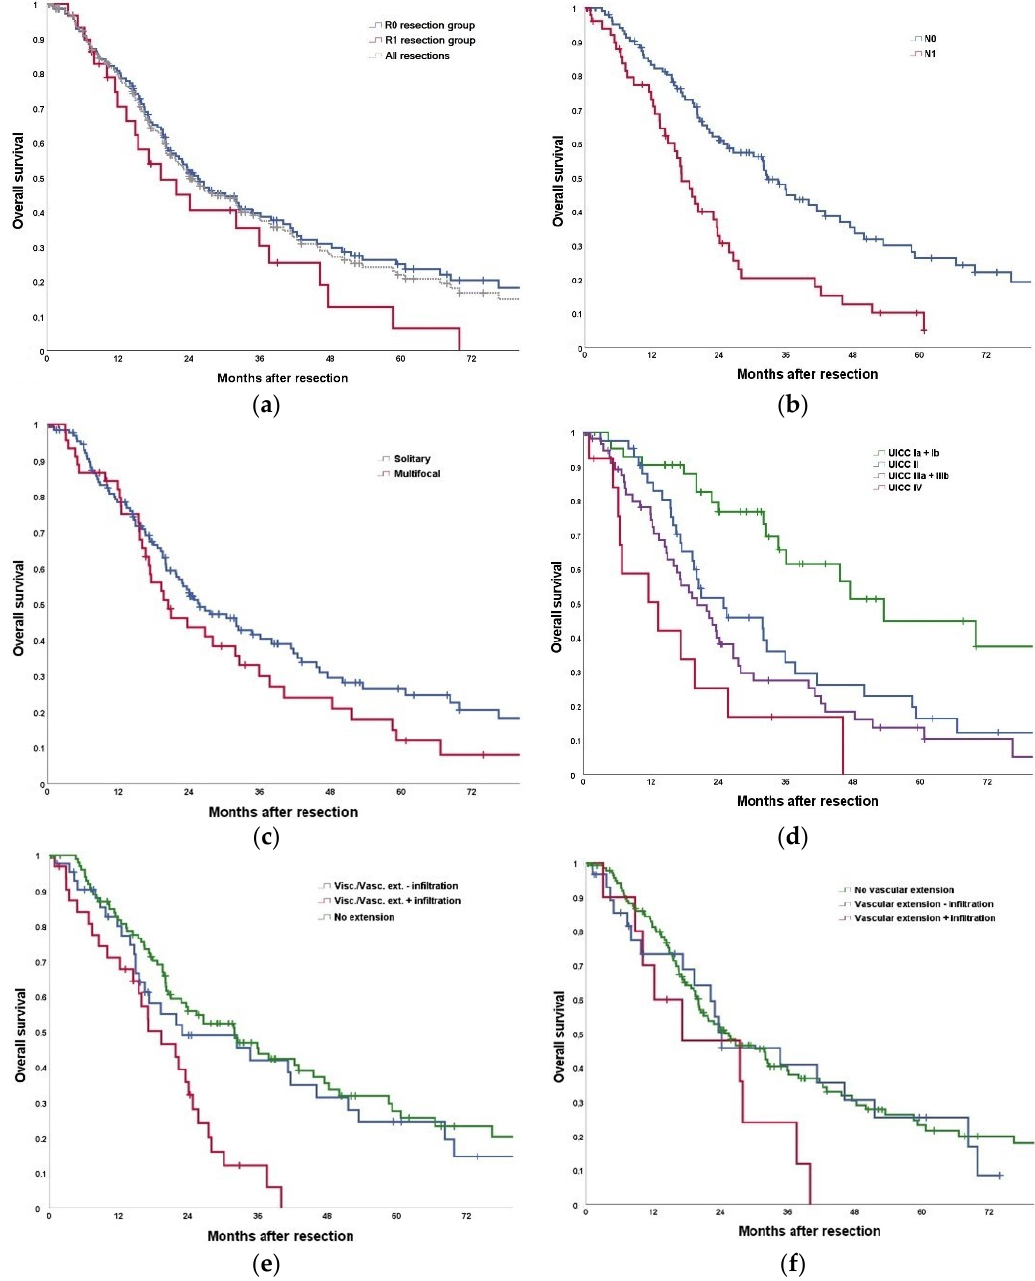
Figure 3. ( a ) Comparison of overall survival of patients with R0 versus R1 resection; p = 0.092. Additionally, combined depiction of the complete cohort. Perioperative deaths were excluded. ( b ) Comparison of overall survival of patients with N0 or N1 status; p < 0.001. Perioperative deaths were excluded. ( c ) Comparison of overall survival of patients with solitary versus multifocal iCCA; p = 0.144. Perioperative deaths were excluded. ( d ) Comparison of overall survival of different UICC groups; p < 0.001. Subgroup comparison: UICC I vs. UICC II p = 0.002; UICC I vs. UICC III p < 0.001; UICC I vs. UICC IV p < 0.001; UICC II vs. UICC III p = 0.252; UICC II vs. UICC IV p = 0.014; UICC III vs. UICC IV p = 101. Perioperative deaths and patients with Nx status were excluded. ( e ) Comparison of overall survival of patients with visceral and/or vascular extension (VVE) versus no extension; p < 0.001. Subgroup comparison: no extension vs. VVE − infiltration p = 0.465; no extension vs. VVE + infiltration p < 0.001; VVE − infiltration vs. VVE + infiltration p = 0.007. Perioperative deaths were excluded. ( f ) Comparison of overall survival of patients without vascular extension (VE), VE without ( − ) infiltration and VE with (+) infiltration; p = 0.163. Subgroup comparison: no VE vs. VE − infiltration p = 0.746; no VE vs. VE + infiltration p = 0.058; VE − infiltration vs. VE + infiltration p = 0.125. Perioperative deaths were excluded.